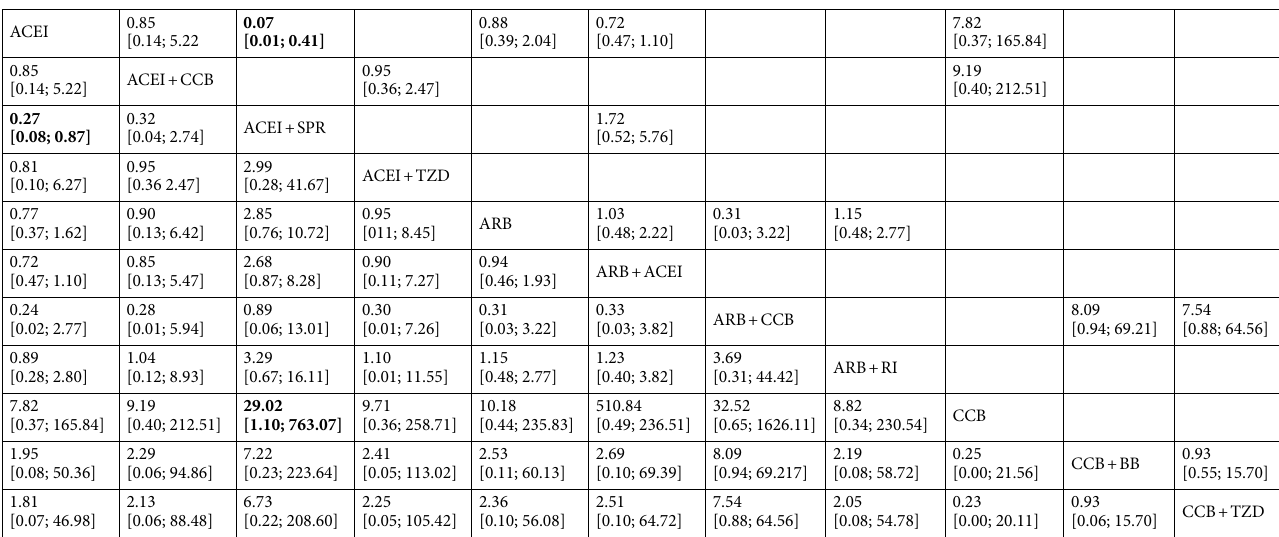
Table 5. Net league table of hyperkalemia. ACEI, angiotensin converting enzyme inhibitors; ARB, angiotensin receptor blockers; BB, beta-blocker; CCB, calcium channel blockers; RI, renin inhibitor; SPR, spironolactone; TZD, thiazide diuretics. Statistically significant values are expressed in